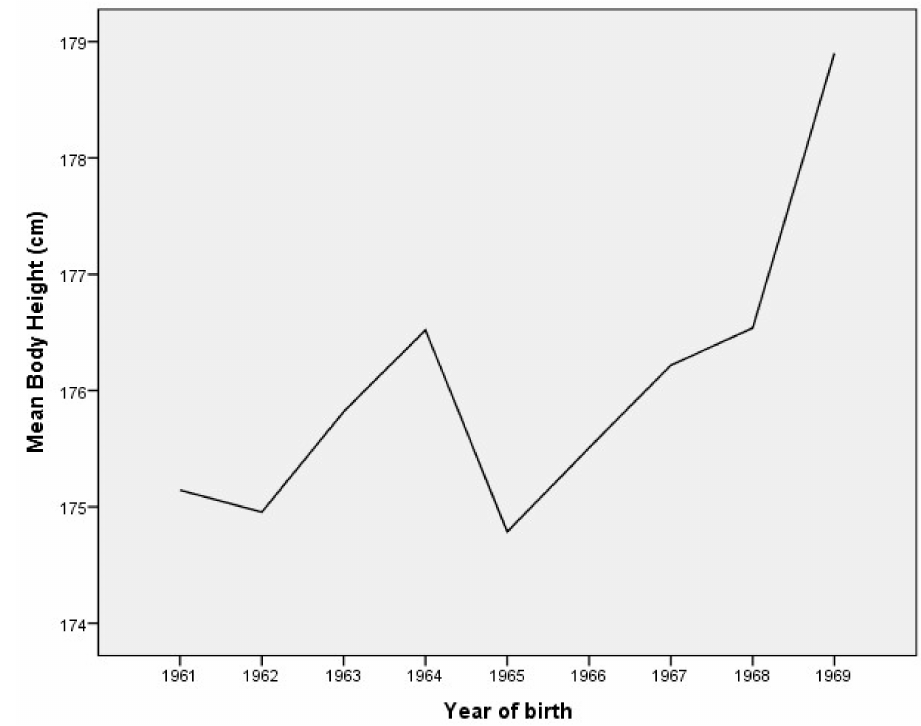
Figure 1. The mean body height trends by year of birth in young